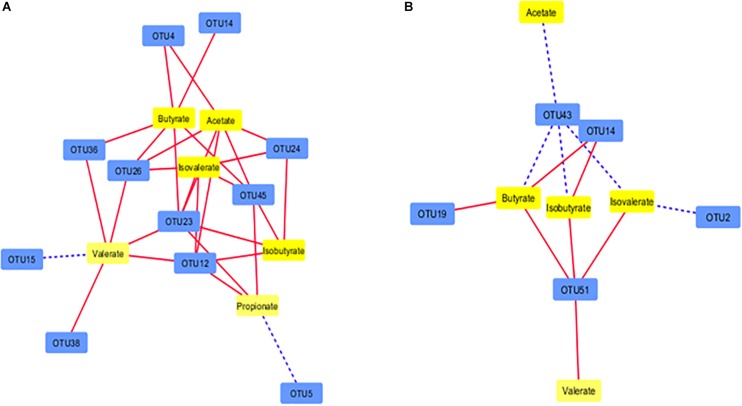
Correlation network showing the correlation between major OTUs (each representing ≥0.1% of total sequences) in the digesta and SCFAs of ruminal fluid in the Control group (A) and both PBLC-L and PBLC-H groups (B). Control, PBLC-L, and PBLC-H, treatment groups supplemented with menthol-rich PBLC at 0, 80, and 160 mg/d, respectively. Dotted lines indicate positive correlations, whereas solid lines represent negative correlations. The shorter the distance between two nodes, the stronger the correlation between them. See Supplementary Table S5 for the taxonomic assignment of the OTUs.